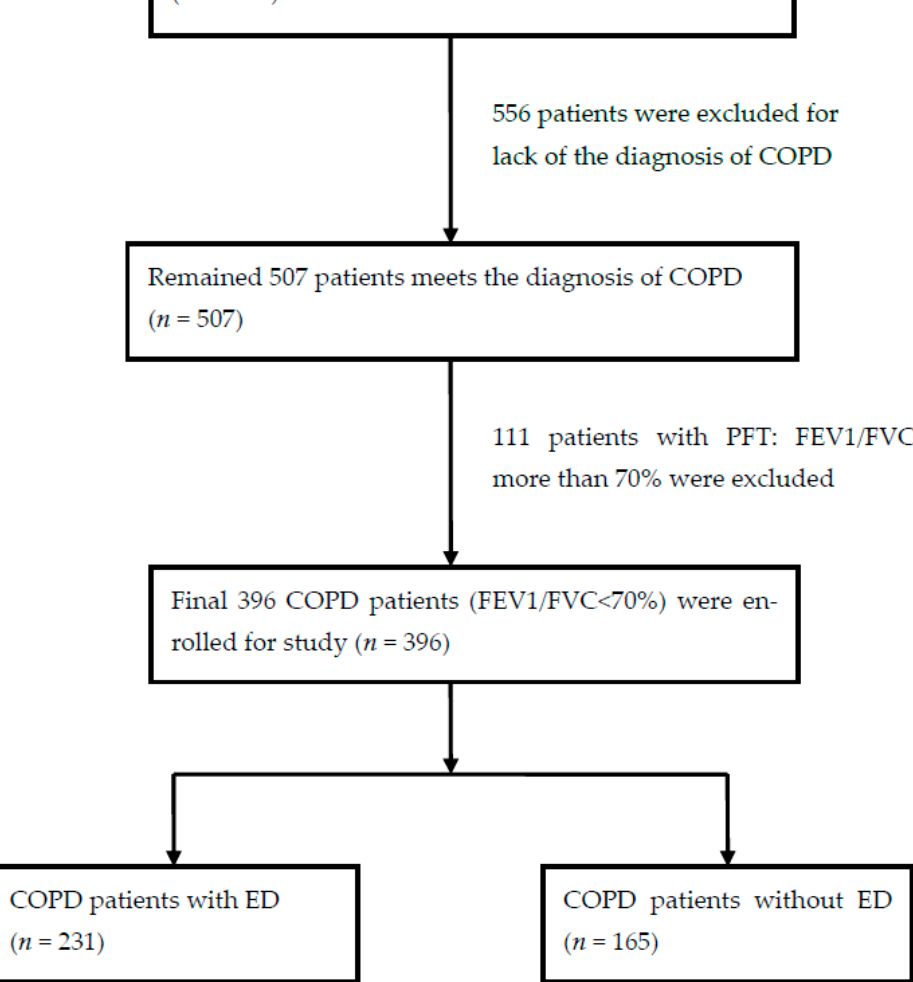
Figure 1. Flow chart of studied patient selection. Abbreviations: 6MWD, six minutes walking test distance; COPD, chronic obstructive pulmonary disease; FEV1, forced expiratory volume in 1st second; FVC, forced vital capacity; ED, Exertional desaturation.